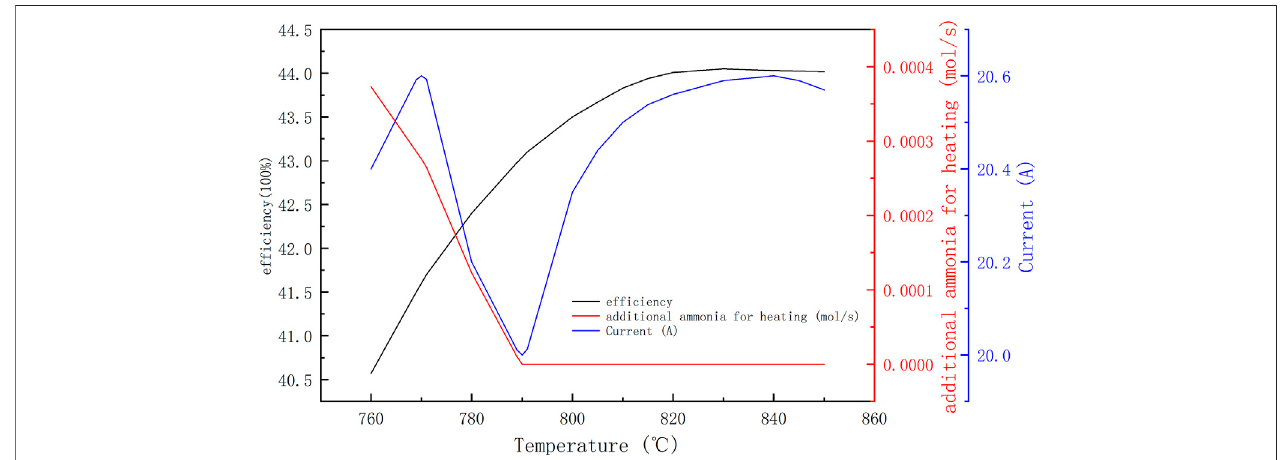
FIGURE 10 | Output characteristics of the system based on experimental data of ammonia